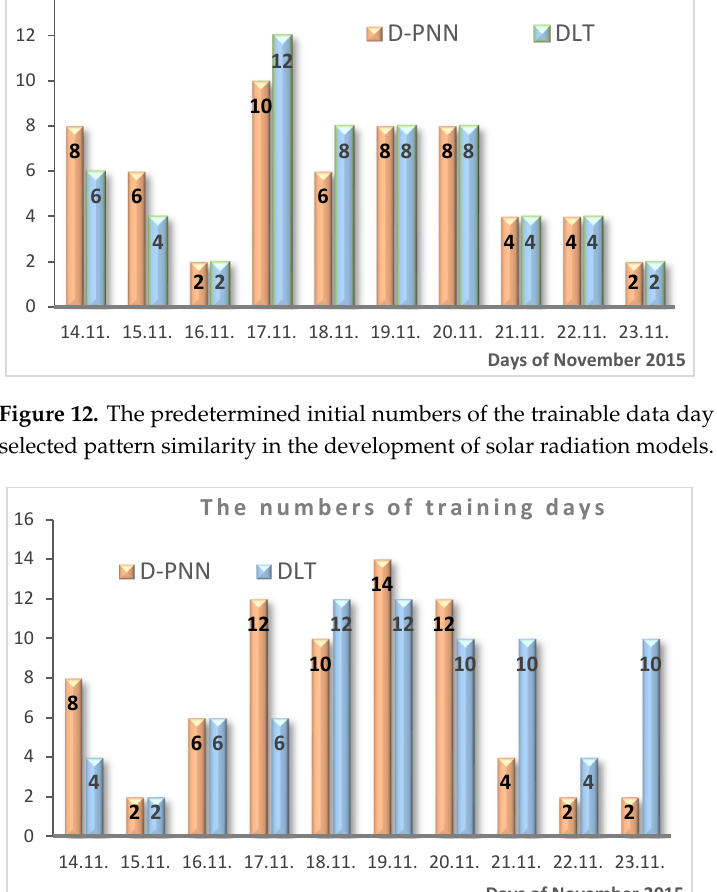
Figure 13. The roughly pre-estimated initial numbers of the trainable day data series applied in the re-evaluation of selected pattern samples in the development of wind speed models.